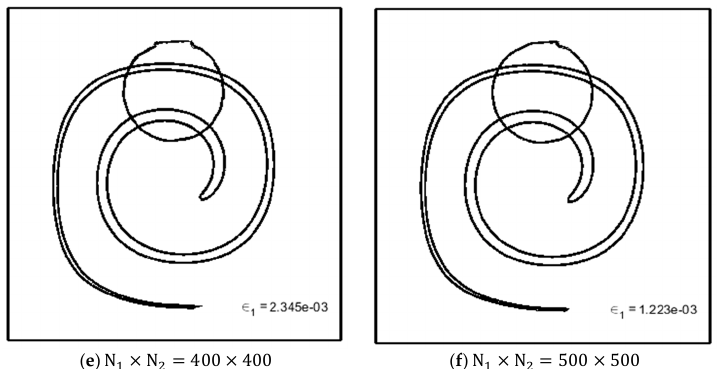
Figure 12. The interface shape in swirling flow vortex at t = 4 and t = 8 for structured meshes with different spacing. The values of the (cid:101) 1 norm is also presented.